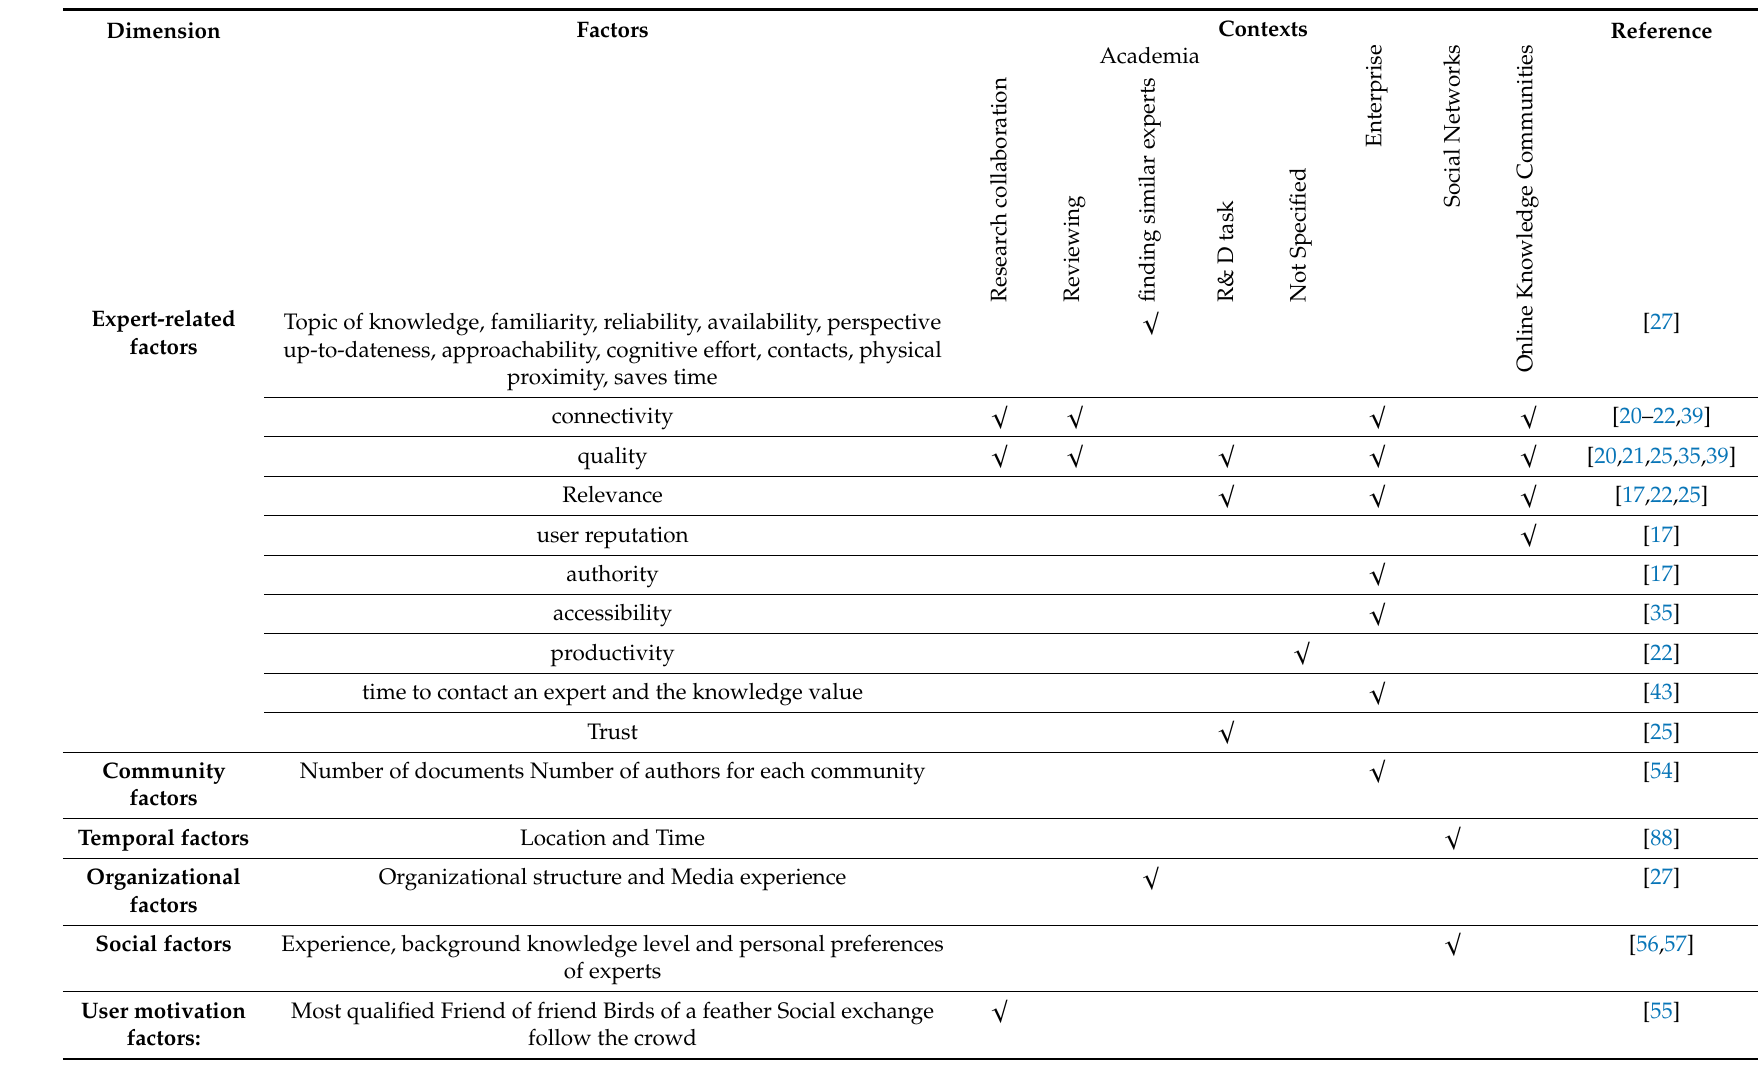
Table 7. Contextual factors in expertise retrieval